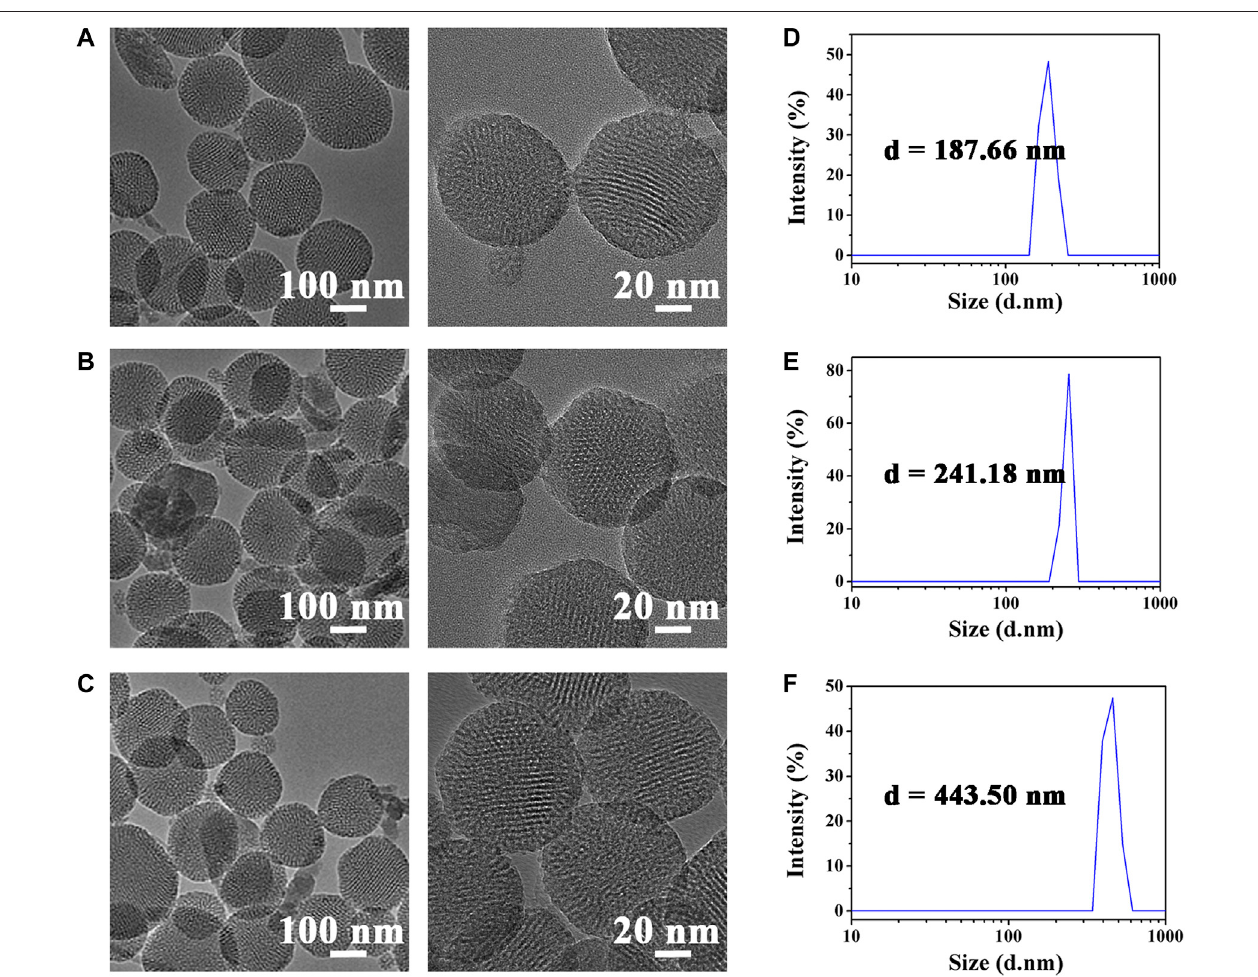
FIGURE 1 | TEM images of HMONs-NH2 (A) , ICG@HMONs (B) , and ICG@HMONs-HA (C) . Average hydrodynamic diameter of HMONs-NH2 (D) , ICG@HMONs (E) , and ICG@HMONs-HA (F) determined by DLS.